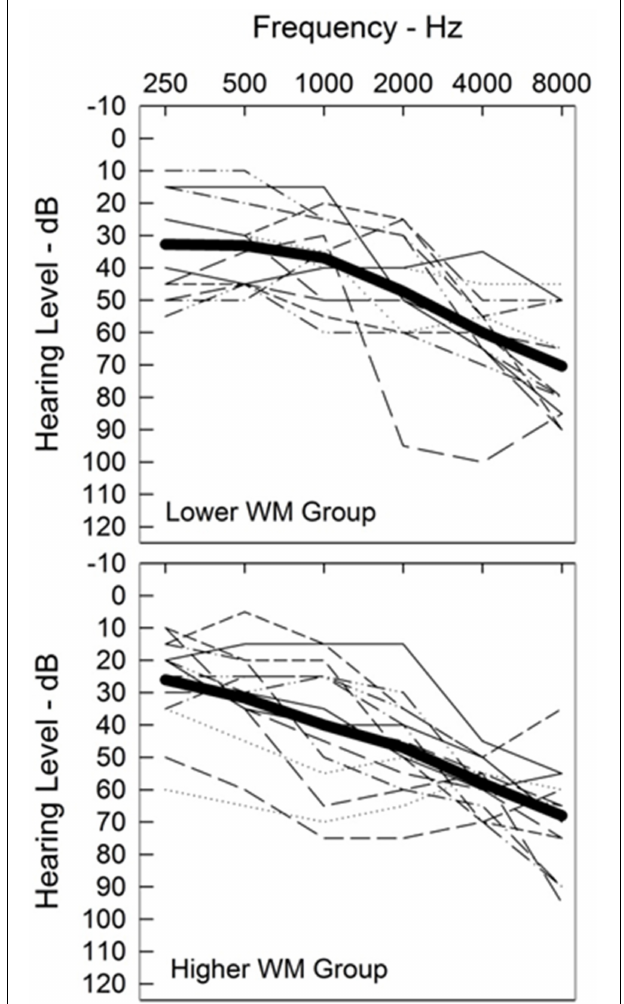
FIGURE 1 | Individual test-ear audiograms (thin lines). Audiograms are grouped by working memory capacity (described in detail later in this paper). Audiograms for participants with lower working memory capacity (WM) are shown in the top panel and with higher working memory in the bottom panel. The average audiogram for each group is shown with a heavy